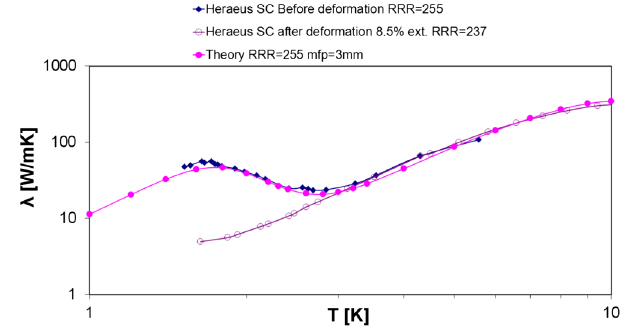
FIG. 5. Plastic deformation influence on thermal conductivity of single crystal niobium.FIG. 4. Thermal conductivity of fine grain, large grain, and